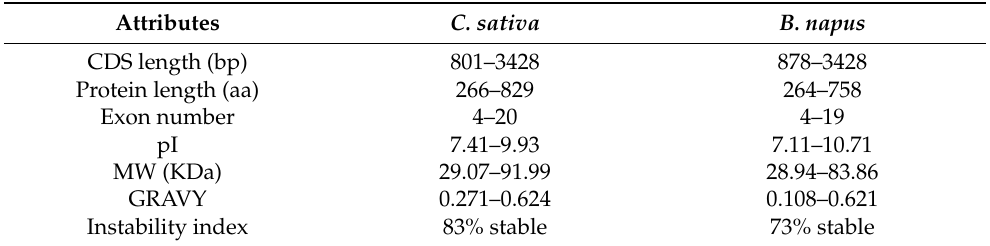
Table 1. Summary of SULTRs properties in Camelina sativa and Brassica napus . Full details of SULTRs properties are provided in Table